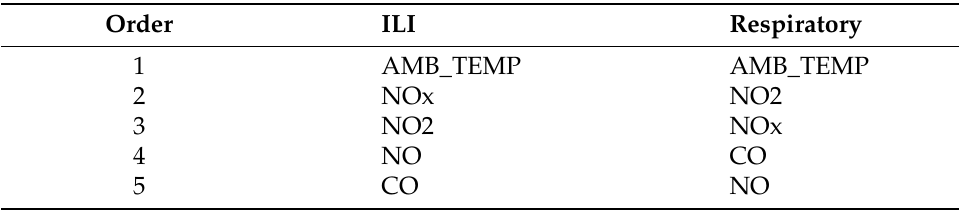
Table 1. Matrix Correlation of ILI and Respiratory Disease.